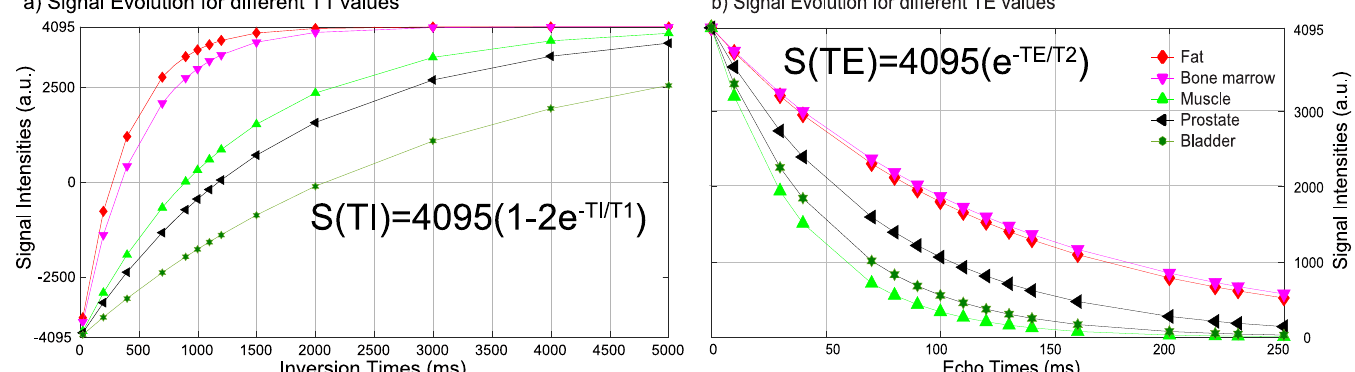
Fig 3. Model of a T 1 and T 2 relaxation signal. The T 1 relaxation curve is simulated with an ideal inversion pulse ( α = 2 = 180˚) and magnetic field homogenization (S 0 = 4095) (a). The T 2 signal is also simulated with magnetic homogenization (S 0 = 4095). Reported T 1 and T 2 values at 3 Tesla from the literature were used to generate the signal: fat (385 ms, 121ms), bone marrow (585 ms, 127 ms), muscle (1295 ms, 40 ms), prostate (1700 ms, 74 ms), and bladder (3000 ms, 50 ms) [24,33,34],respectively. TIs and TEs were chosen to cover the complete span of relaxation times of the previous